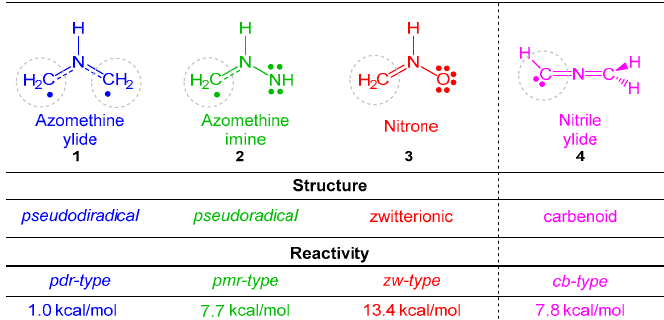
Scheme 1. Electronic structure of simplest TACs and proposed reactivity types in 32CA reactions.